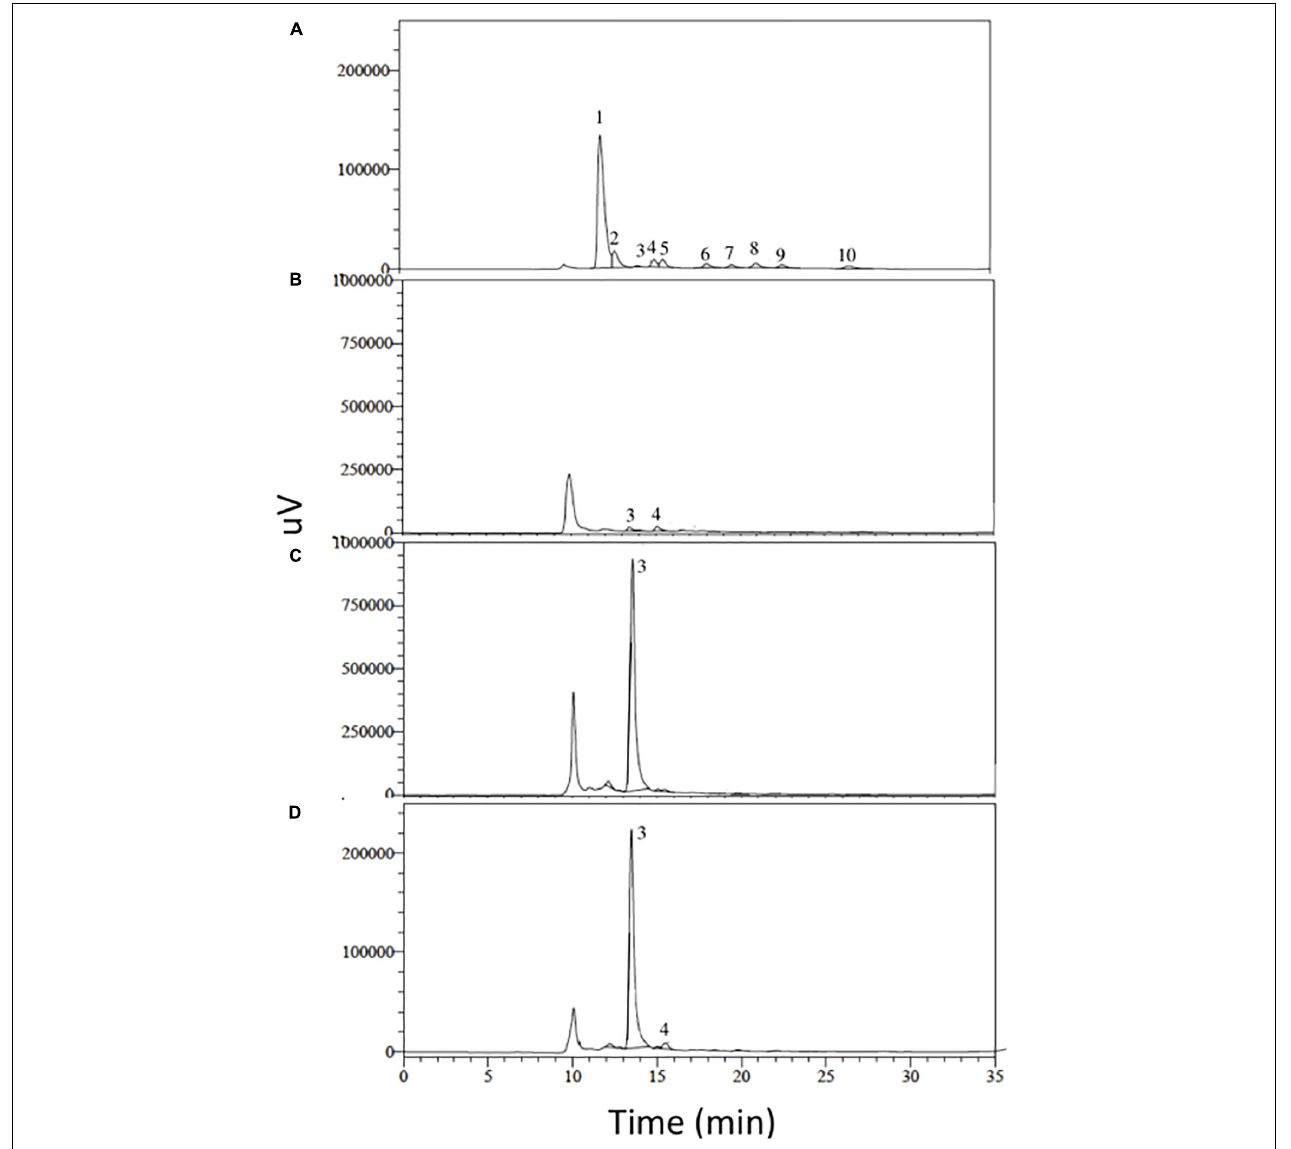
FIGURE 3 | HPLC analysis of organic acids involved in phosphorus solubilization. (A) Chromatographic profile of organic acid standards. (B) Extract of the 3AS4 strain obtained in phytate medium. (C) Extract of the 3AS4 strain obtained in calcium phosphate medium [Ca 3 (PO 4 ) 2 ]. (D) Extract of the 3AS4 strain obtained in Rock Phosphate medium. All extracts were obtained after 12 days of growth in liquid medium under agitation (140 rpm) at 28 ◦ C. Numbers represent the different organic acids used, 1: oxalic acid, 2: citric acid, 3: gluconic acid, 4: 2-ketogluconic acid, 5: malonic acid, 6: succinic acid, 7: lactic acid, 8: formic acid, 9: malic acid, 10: propionic